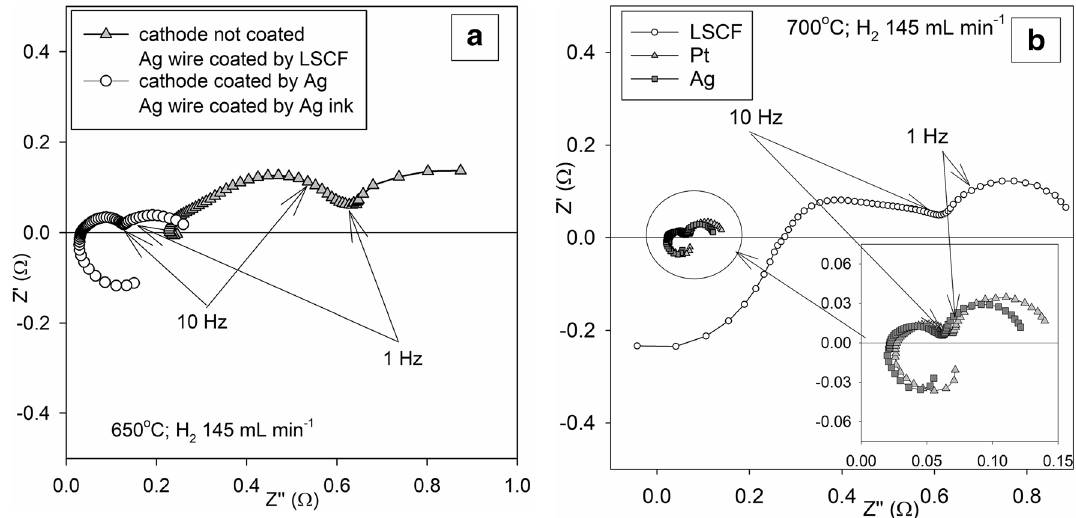
−1 ; b cells with the cathode 2 145 ml min